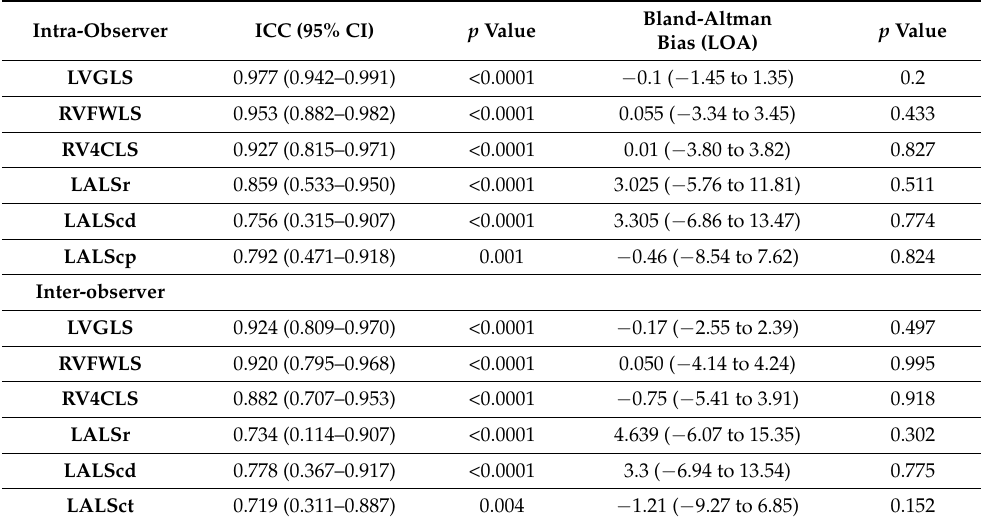
Table 10. The inter- and Intra-observer reproducibility analysis